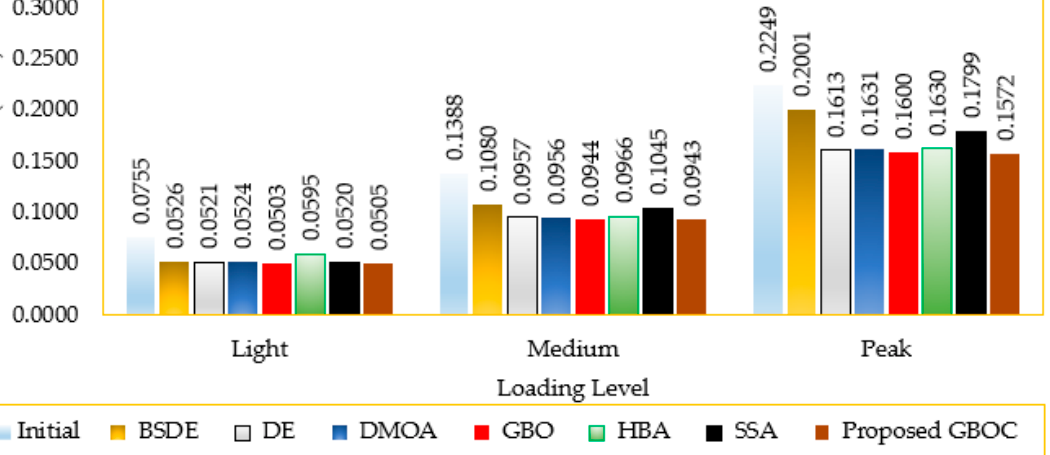
Figure 13. Power losses (MW) in each loading level based on the obtained D-SVC devices in Table 5 compared to the initial case.